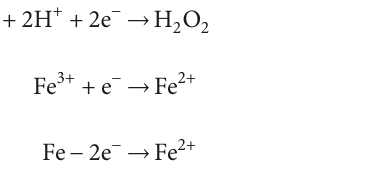
O -FeRe), (5) peroxi-coagulation (EF- H 2 2